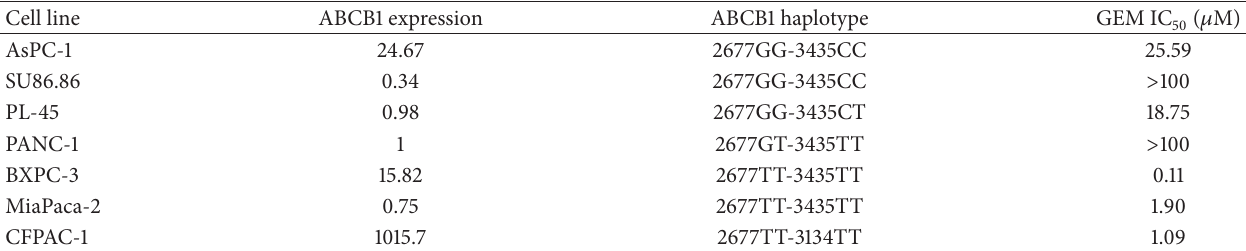
Figure 3: Expression of ABCB1 based on G2677T-C3435T haplotypes. The mRNA expression of ABCB1 in carriers of 2677TT-3435TT haplotype was compared to those of all the other haplotypes in European Americans. Values are expressed as means ± SEM and ∗ 𝑃 < 0.05 . Table 4: Pancreatic cancer cell line ABCB1 mRNA expression, haplotype, and sensitivity to